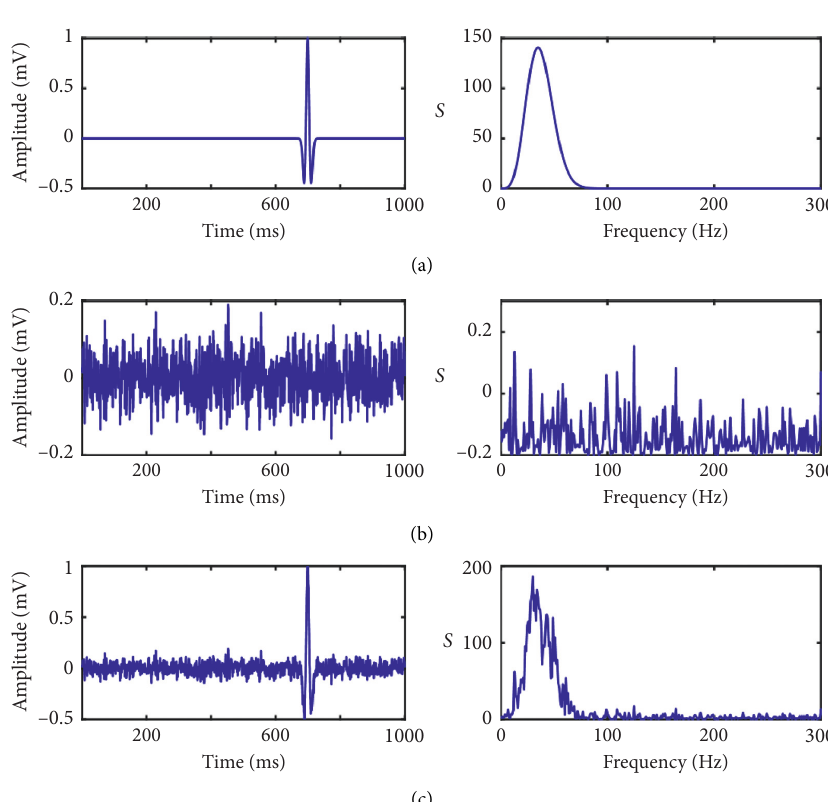
Figure 4: Synthetic signals: (a) Ricker wavelet, (b) white Gaussian noise, and (c) synthetic signal.